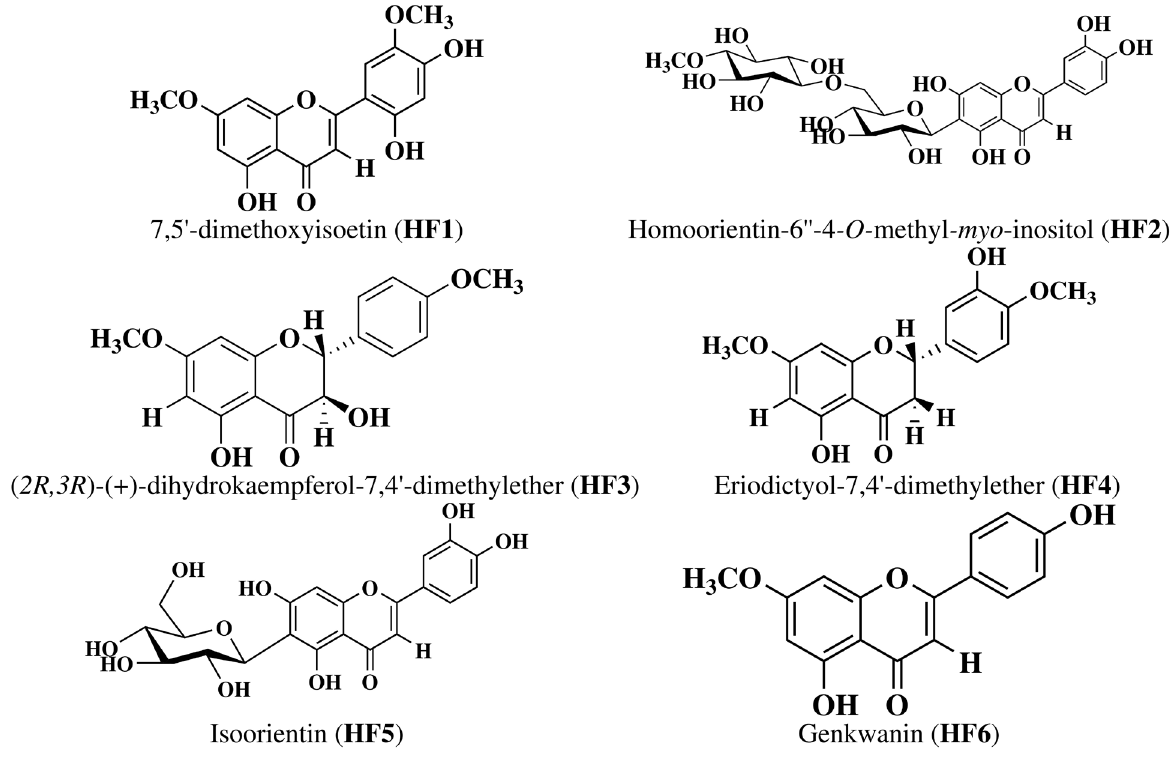
Figure 1. The chemical structures of flavonoids ( HF1-6